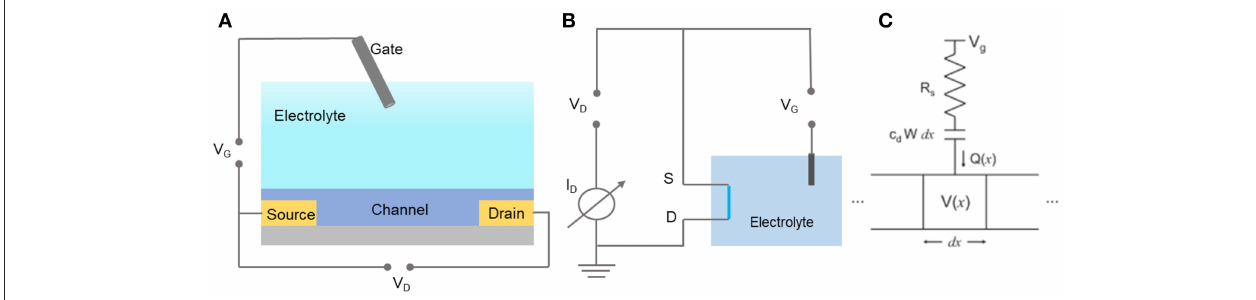
FIGURE 3 | The schematic configuration of OECT sensor (A) and it’s equivalent circuit (B) . (C) The typical ionic and elctronic circuit (Bernards and Malliaras, 2007). Reproduced with permission (Bernards and Malliaras, 2007). Copyright © 2007 Wiley-VCH Verlag GmbH & Co. KGaA, Weinheim.